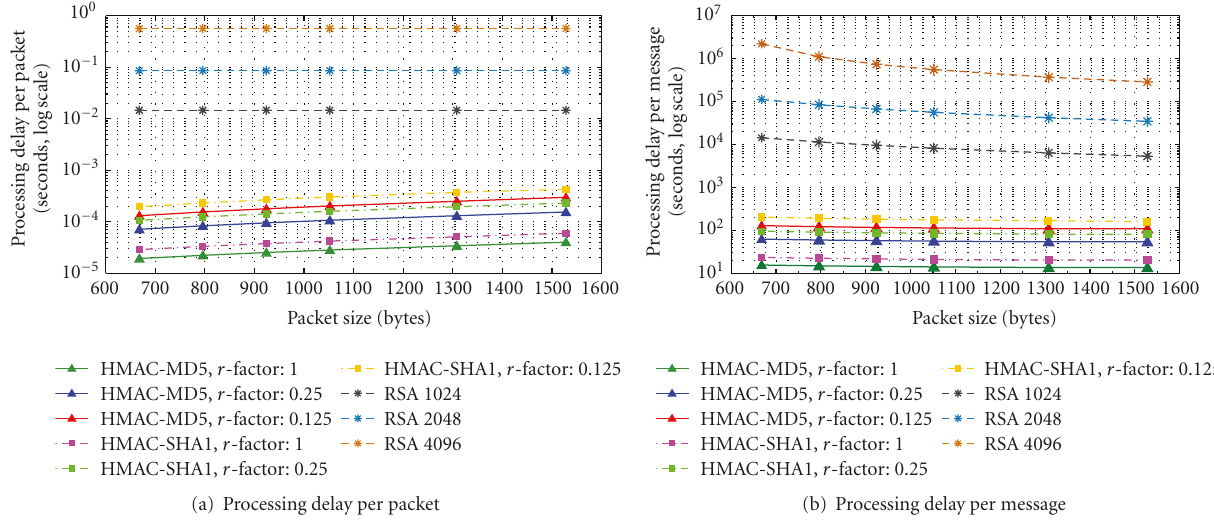
Figure 11: Comparison of authentication processing delay for 500MB data, PIII500MHz.